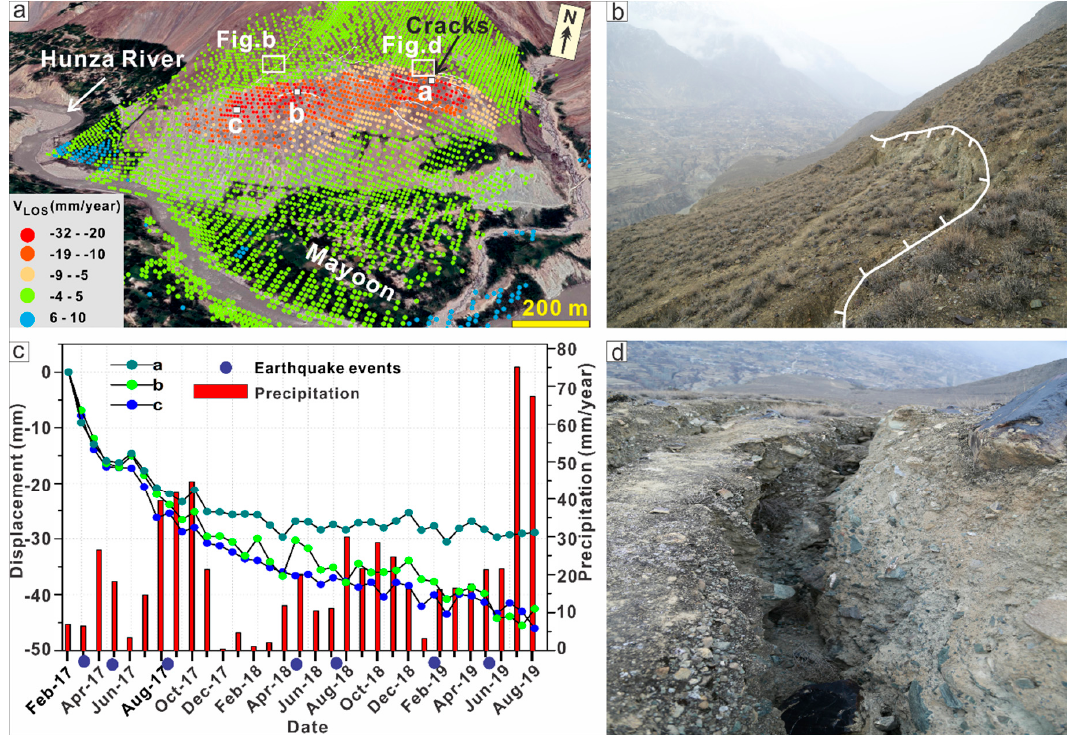
Figure 7. Mayoon landslide. (a) The LOS displacement rates in the Mayoon landslide as superimposed on Google Earth map for a perspective view; (b and d) shows cracks for the locations as marked on (a); and (c) the displacement time series for three representative pixels a, b, and c, respectively.